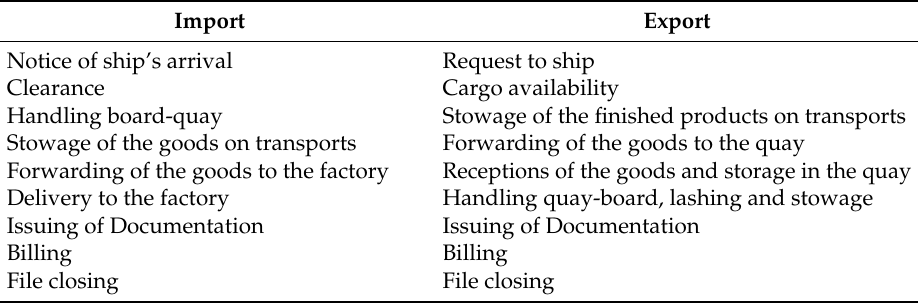
Table 1. Operations of import and export of the two